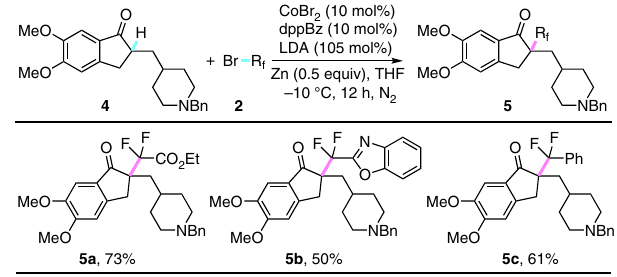
Fig. 3 Late-stage di fl uoroalkylation of biologically active molecules. Conditions: 4 (0.2 mmol, 1.0 equiv), 2 (3.0 equiv), CoBr 2 (10 mol%), dppBz (10 mol%), LDA (105 mol%), Zn (0.5 equiv), THF (2.0 mL), − 10 °C, 12